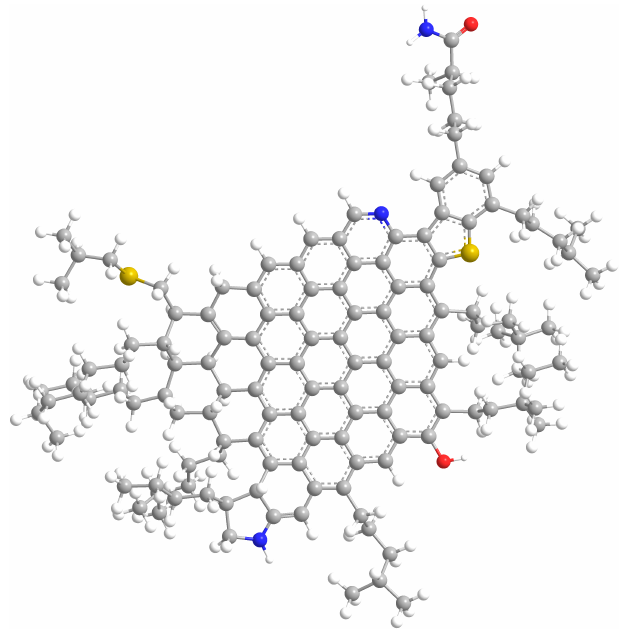
Figure 37. Example of an asphaltene molecule. The blue atoms represent nitrogen, red atoms oxygen, white atoms hydrogen, yellow atoms sulfur, and grey atoms carbon. Figure adapted from Ref. [165].